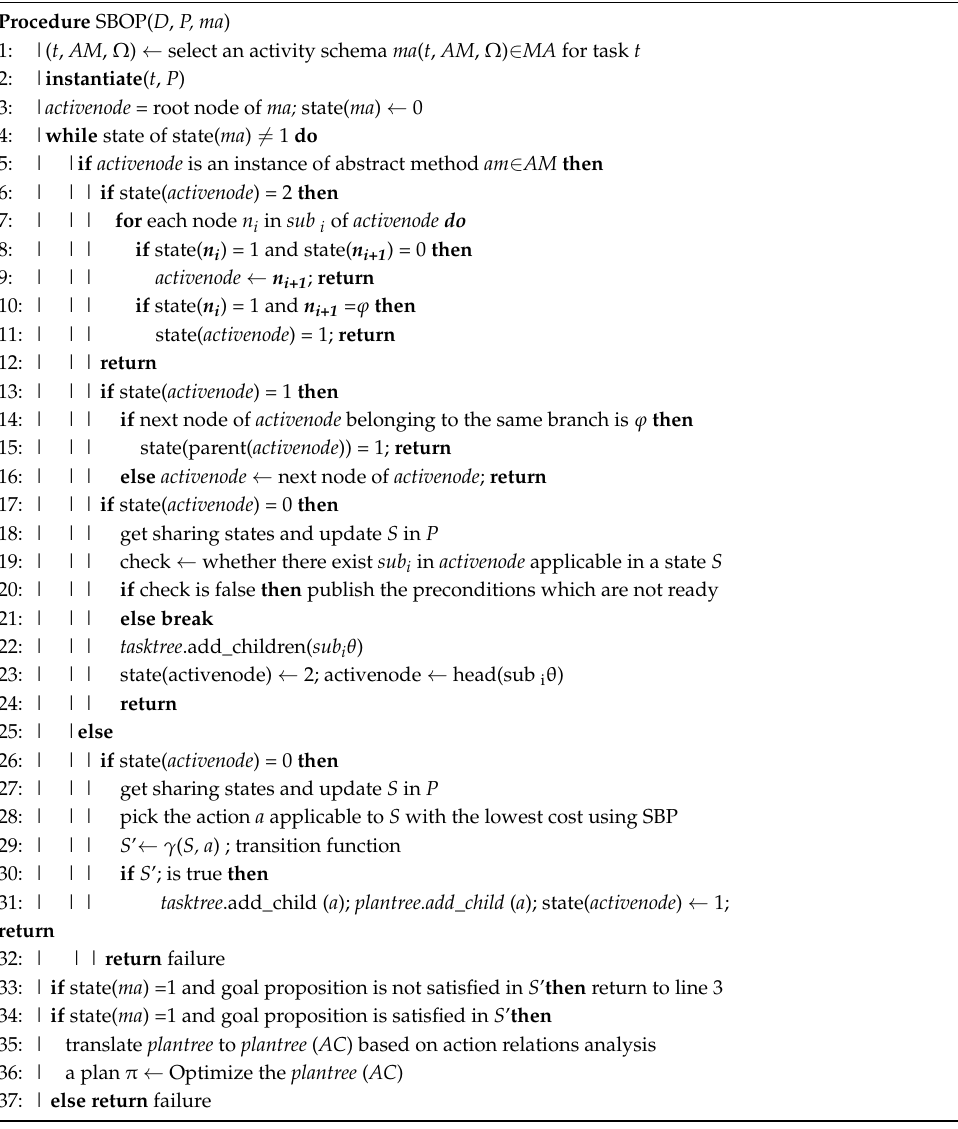
Algorithm 2 Schema-Based Optimized Planner